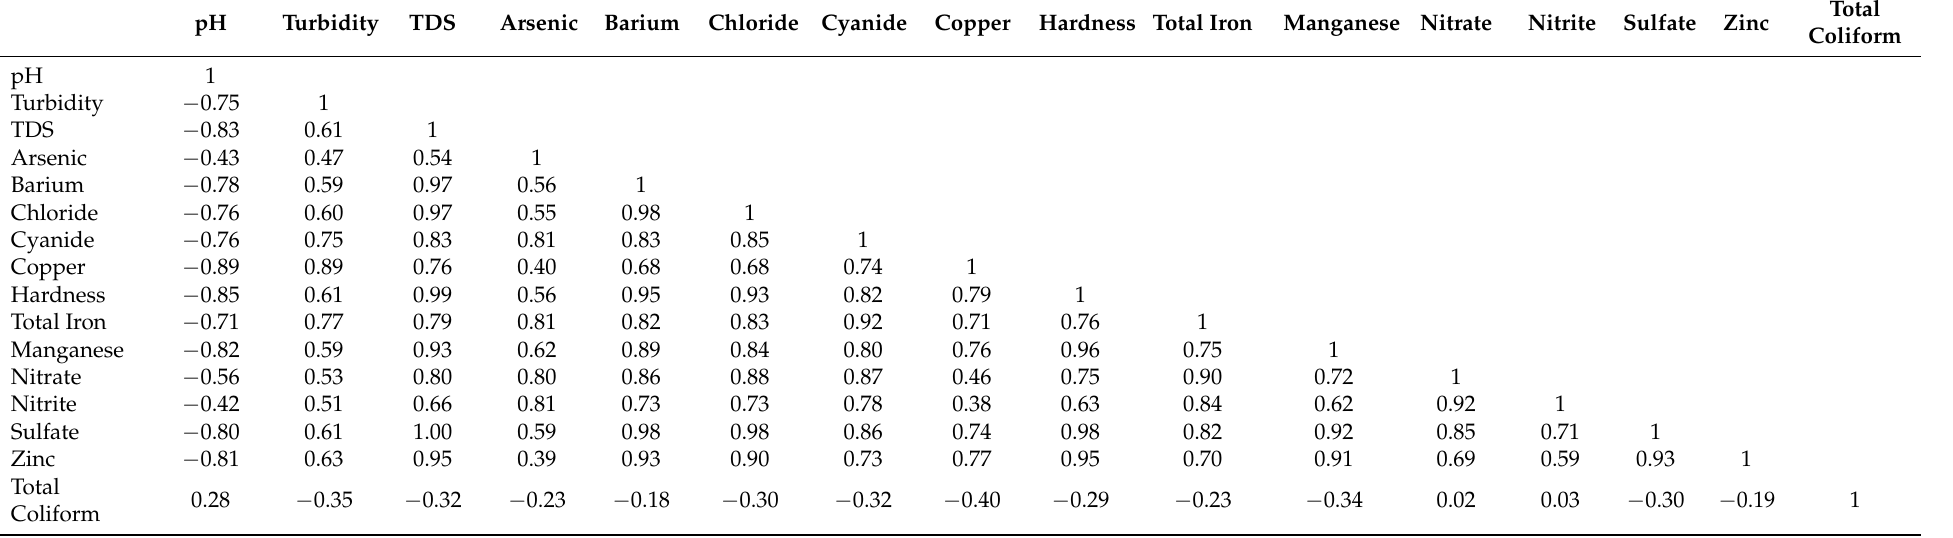
Table 6. Correlation matrix for all of the